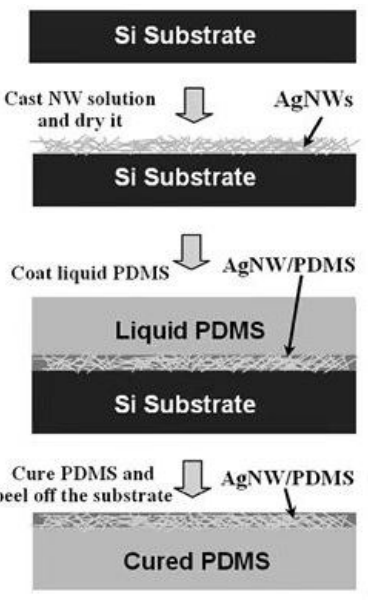
Figure 6. Schematic showing the fabrication process of AgNW/PDMS stretchable conductors. Reprinted with permission from [81]. Copyright 2012 John Wiley and